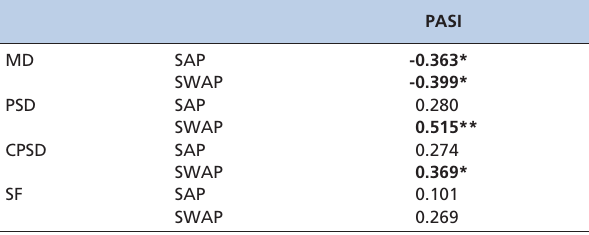
Table 3 - Correlation between visual field parameters and the psoriasis activity and severity index